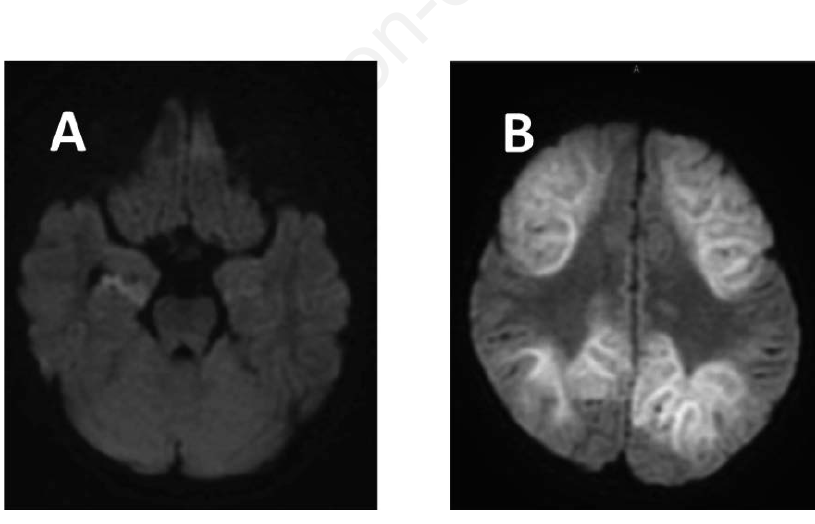
Figure 1. Magnetic resonance imaging diffusion weighted imaging on day 2 showed a localized high signal intensity in the right temporal lobe (a left parietal lobe lesion is